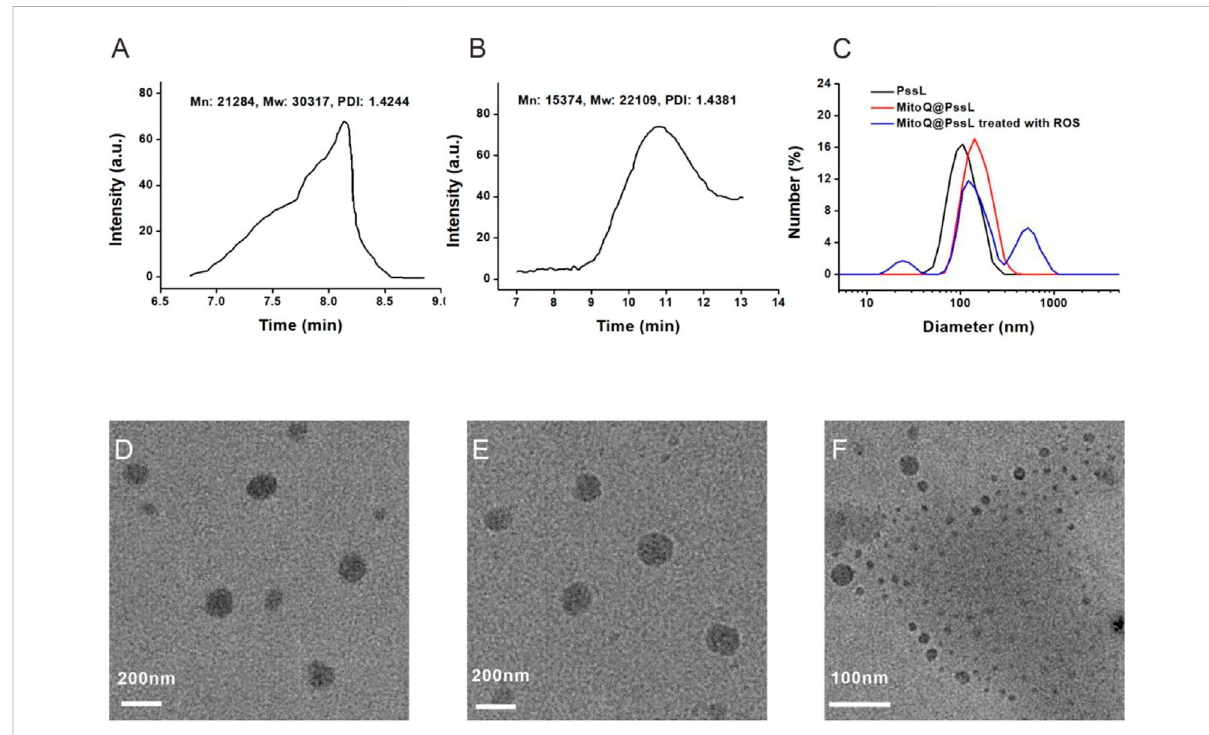
FIGURE 1 Characterization of MitoQ@PssL NPs. (A) GPC of PssL. (B) GPC of PssL treated with ROS. (C) DLS pro fi les. (D) TEM image of PssL NPs. (E) TEM image of MitoQ@PssL NPs. (F) TEM image of MitoQ@PssL NPs treated with ROS (0.5 mmol/L H2O2, 4